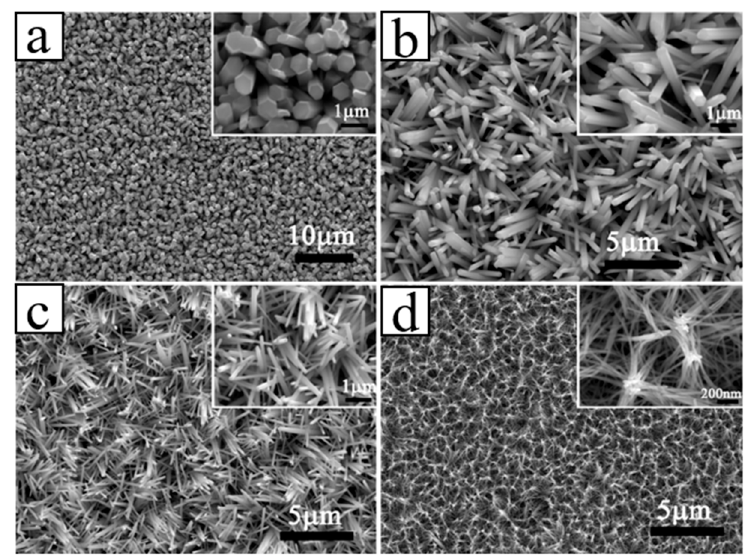
Figure 10. SEM micrographs with different morphologies (the insets) of the fabricated ZnO NRs based on various reaction concentrations: ( a ) 0.1, ( b ) 0.05, ( c ) 0.025 and ( d ) 0.01 mol/L [82].